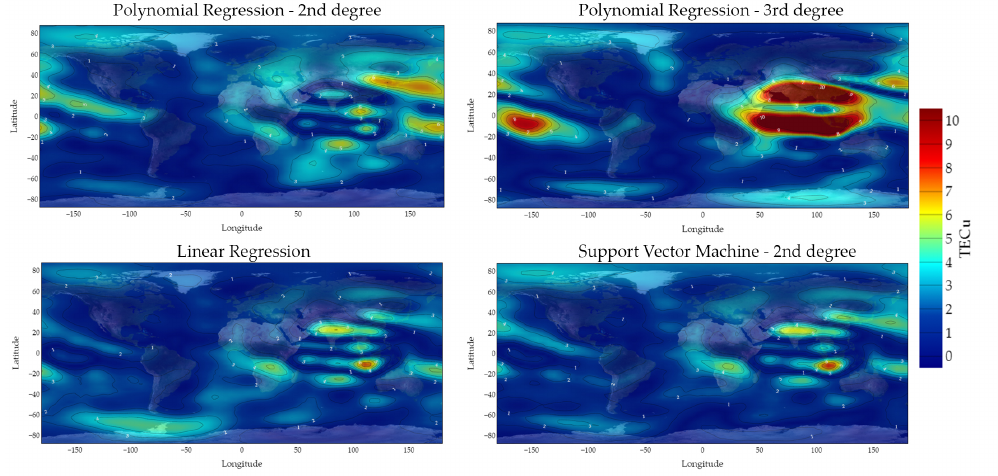
Figure 15. Absolute difference comparison between each reconstructed TEC map and IGS TEC